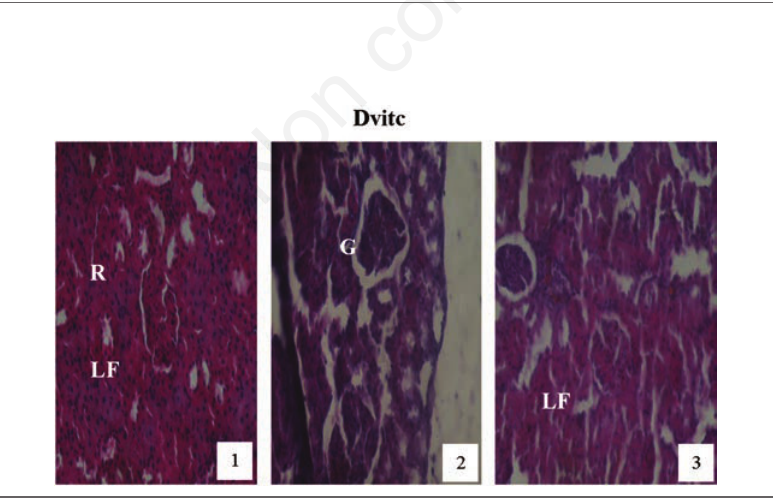
Figure 13. Hematoxylin and eosin staining after administration of 6 mg/kg of paraquat representing test subgroups maintained with vitamin C medicated drinking water (1 g/L) for a period of 3 months (original magnification 400X). The slide at month (1) is show- ing a picture of shrunken Bowman’s capsules and glomeruli (G) with leucocytes infiltra- tion (LF), progressing to renal vascular congestion (R) and leucocyte infiltrations (LF) at month (2). At month (3) the picture indicated advanced renal tubular hypertrophy (R), leucocyte infiltrations (LF), interlobular vacuolation with glomerular (G) and tubular degeneration. Changes increased in an exposure time dependent